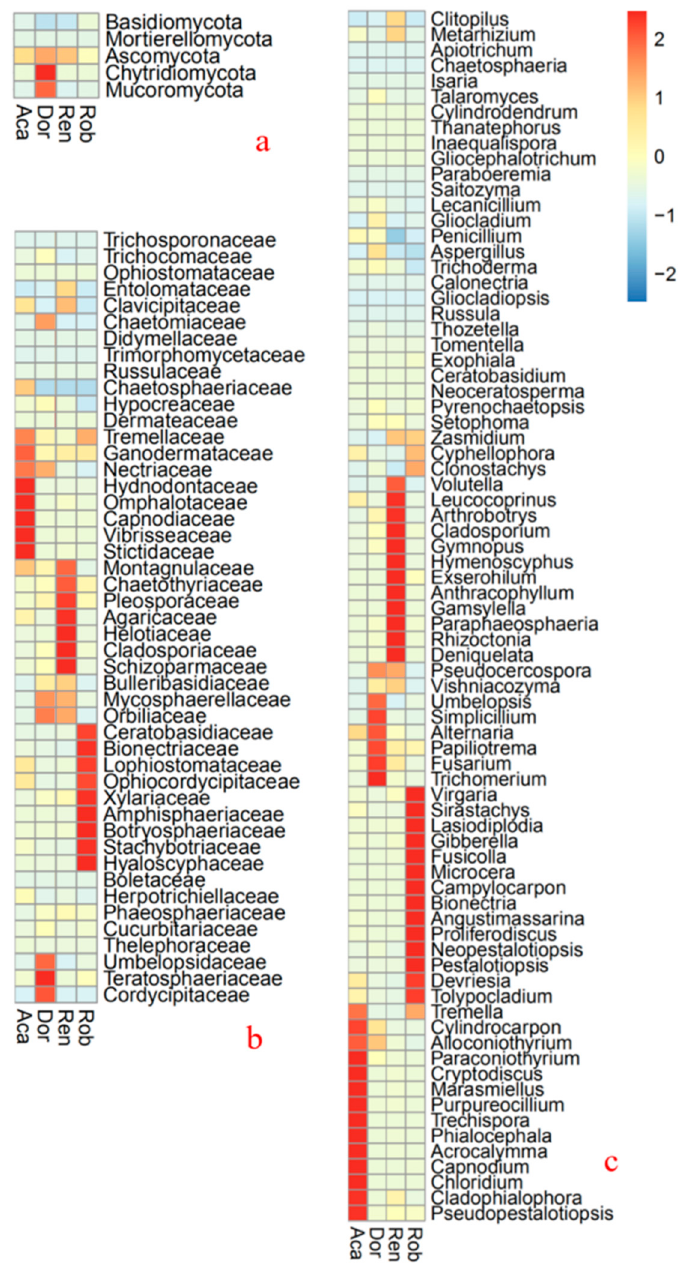
Figure 4. The distribution of different fungal taxa among orchid roots. The heatmap shows the distribution of relatively abundant fungal operational taxonomic units (OTUs; >1000 reads) among the roots of the four wild orchid species. The diversity of the endophytic fungi at different taxonomic levels (( a ) phylum, ( b ) family, and ( c ) genus level). The diversity of the RAF at the family level clearly differed between samples. There were seven dominant families in A. rigida roots, including Stictidaceae, Vibrisseaceae, and Capnodiaceae. In the D. pulcherrima roots, the dominant families were Teratosphaeriaceae, Umbelopsidaceae, and Cordycipitaceae. There were seven dominant families in the R. coc ‐